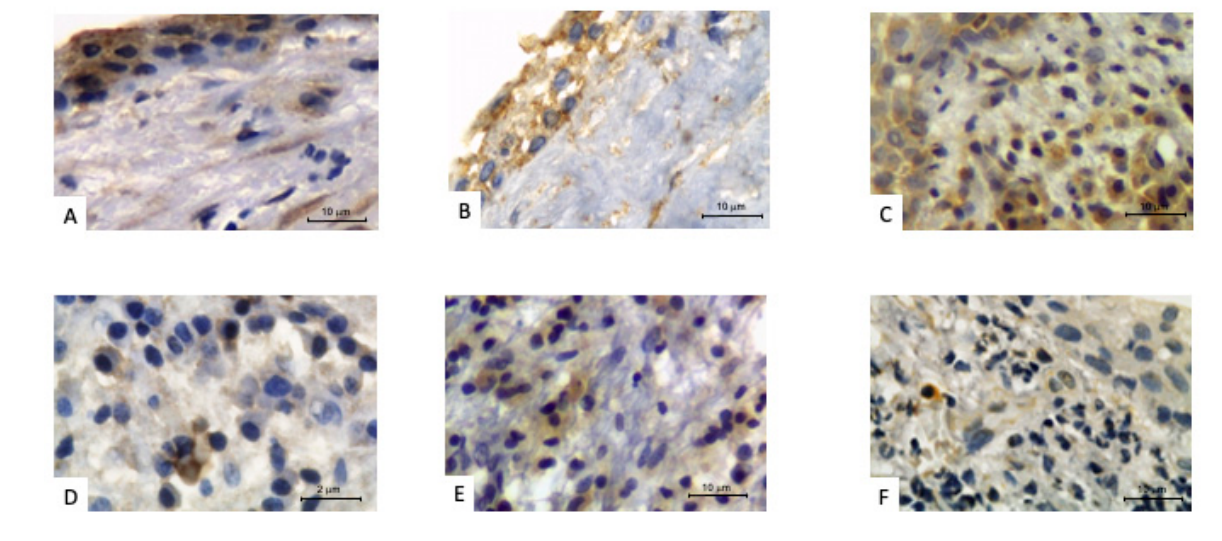
Figure 2. Periradicular cysts with positive immunoperoxidase staining for pro-inflammatory cytokines. Older patient: ( A ) IL-1 β , ( B ) IL-6 and ( C ) TNF- α . Younger/middle-age adult patient: ( D ) IL-1 β , ( E ) IL-6 and ( F ) TNF- α . Table 2. Comparative analysis of the expressions of the pro-inflammatory cytokines in granulomas and apical cysts of young/middle-aged and elderly